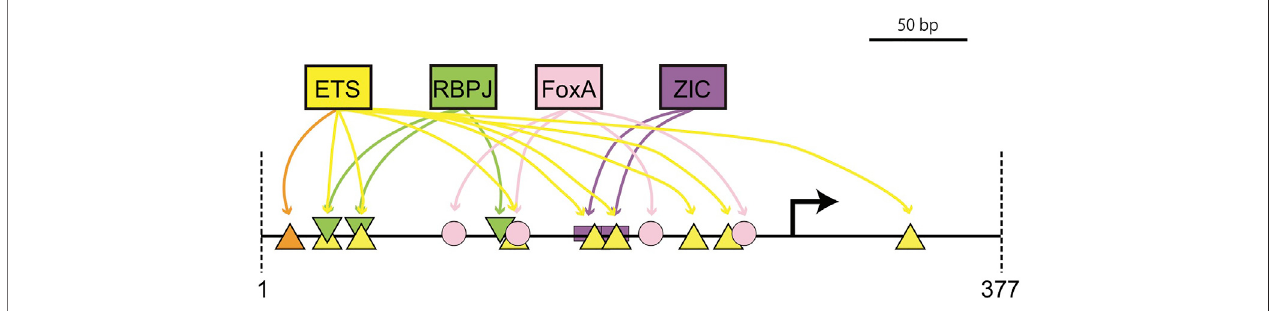
FIGURE 8 | Cis-regulatory model for the proximal bra enhancer. Schematic diagram of major cis-regulatory inputs to the proximal bra enhancer showing the physical overlap between important predicted ETS and RBPJ sites. Orange and yellow triangles indicate high and low af fi nity ETS sites respectively.